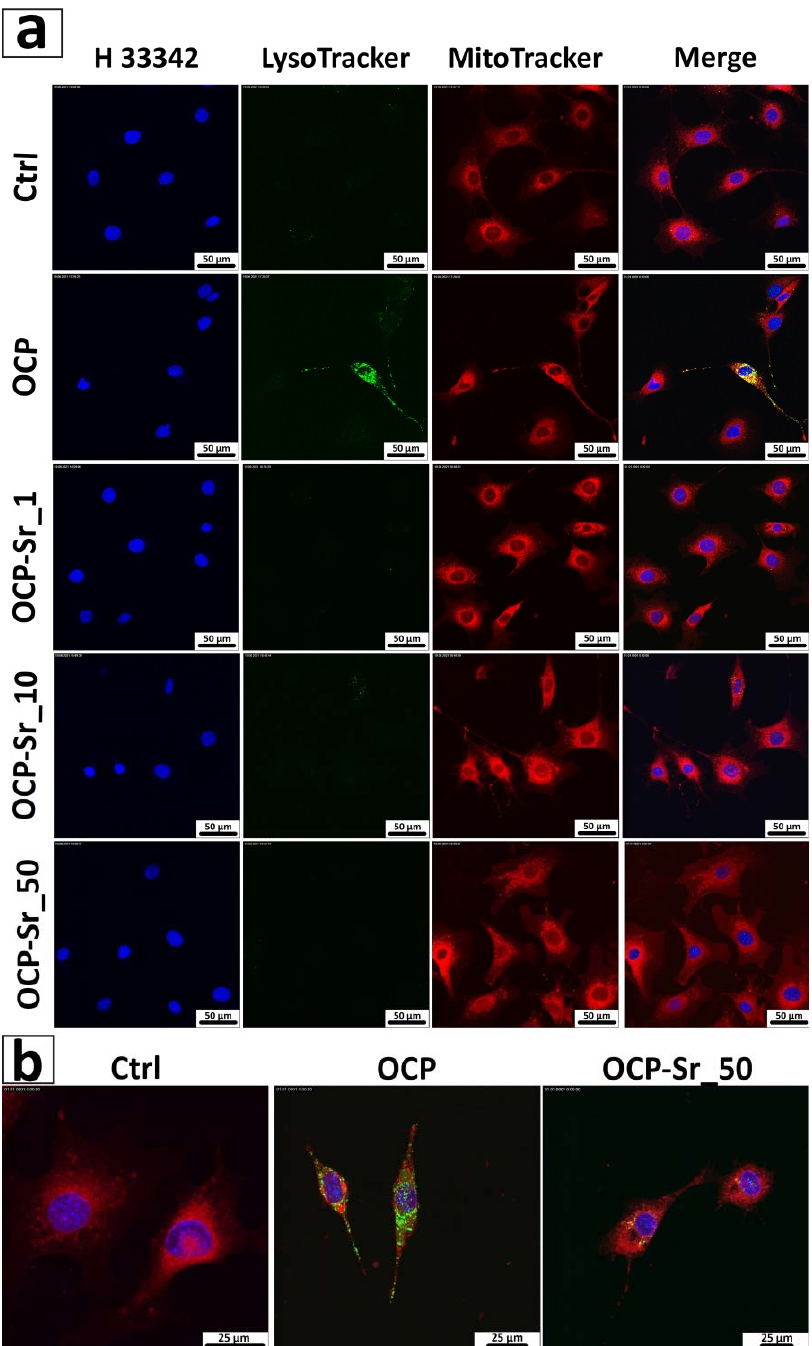
Figure 7. Confocal micrographs ( a , b ) of C 3 H/10T1/2 cells after 96 h of incubation with 1 mg/mL OCP and OCP-Sr. Cell nuclei are stained with Hoechst 33342 (blue), acidic compartments are stained with LysoTracker Green DND-26 (green), and mitochondria are stained with MitoTracker Red CMXRos (red). It is well known that reactive oxygen species (ROS) play a key role both in the regu- lation of normal cell physiology and in various cellular pathologies, including cell damage